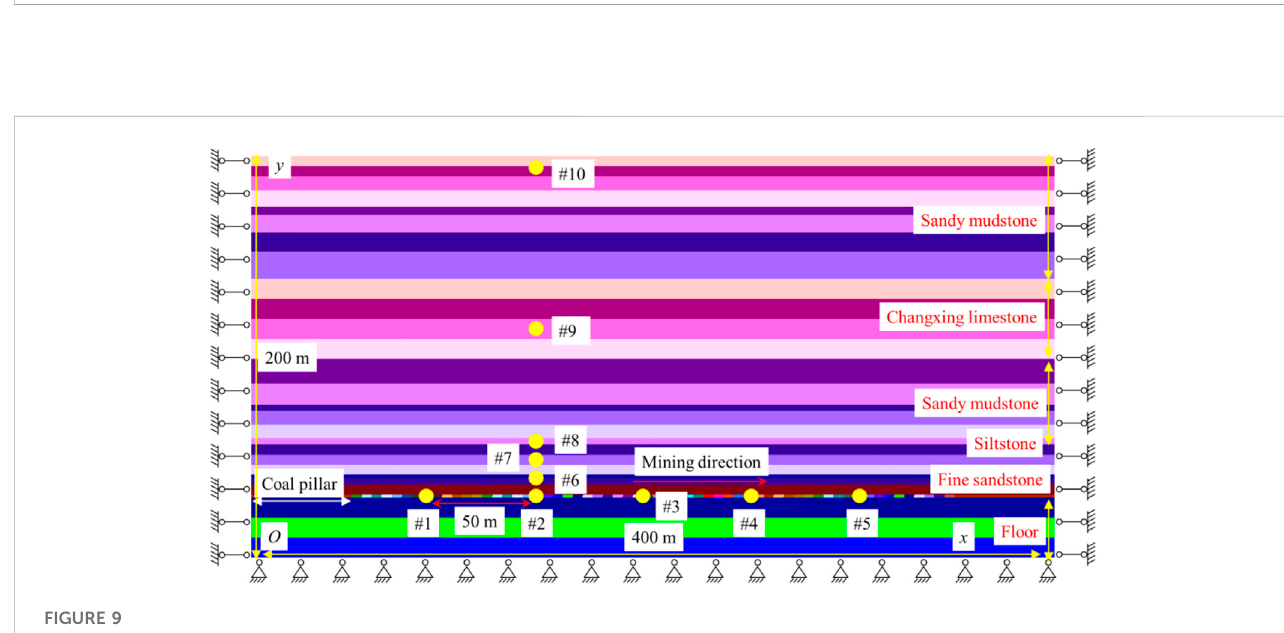
FIGURE 8 In fl uence of the maximum edge length of the rigid block on the rock mass strength. (A) Uniaxial compression stress – strain curve. (B) Direct tension stress – strain curve. (C) Effect of the maximum edge length on the compressive strength. (D) Effect of the maximum edge length on the tensile strength.